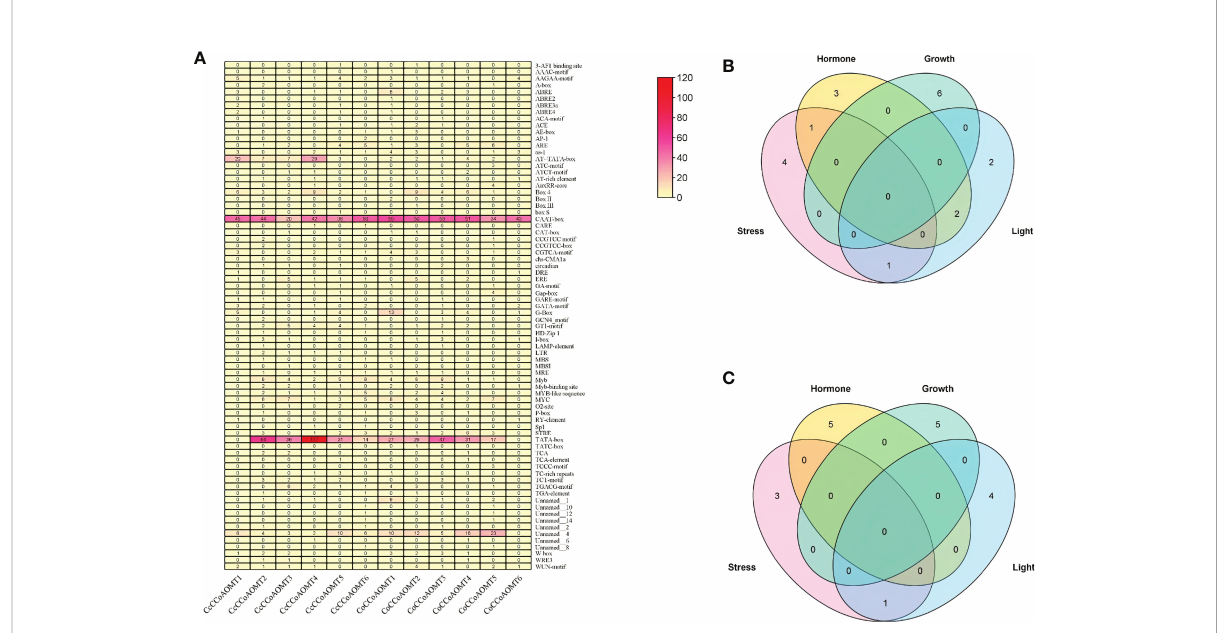
FIGURE 5 Study of the cis-regulatory elements present in the 2kb upstream putative promoter region of CCoAOMT genes in jute. (A) Total number of different cis-elements present in two species of Jute. The total number of cis-elements in each CCoAOMT gene of C capsularis (B) and C olitorius CCoAOMT in four categories is depicted by Venn diagram (C)